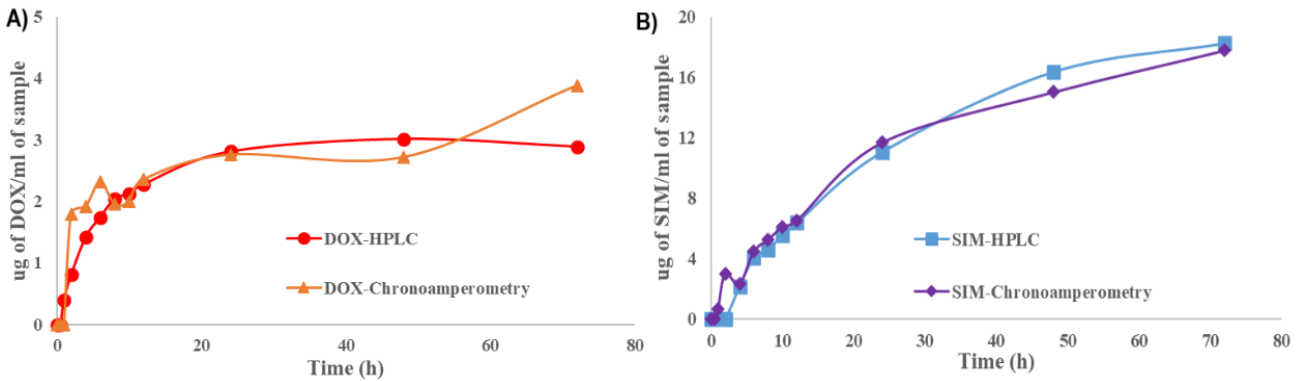
Figure 7. Comparison of the two analytical techniques for the release of DOX ( A ) and SIM ( B ) from the optimal formulation.